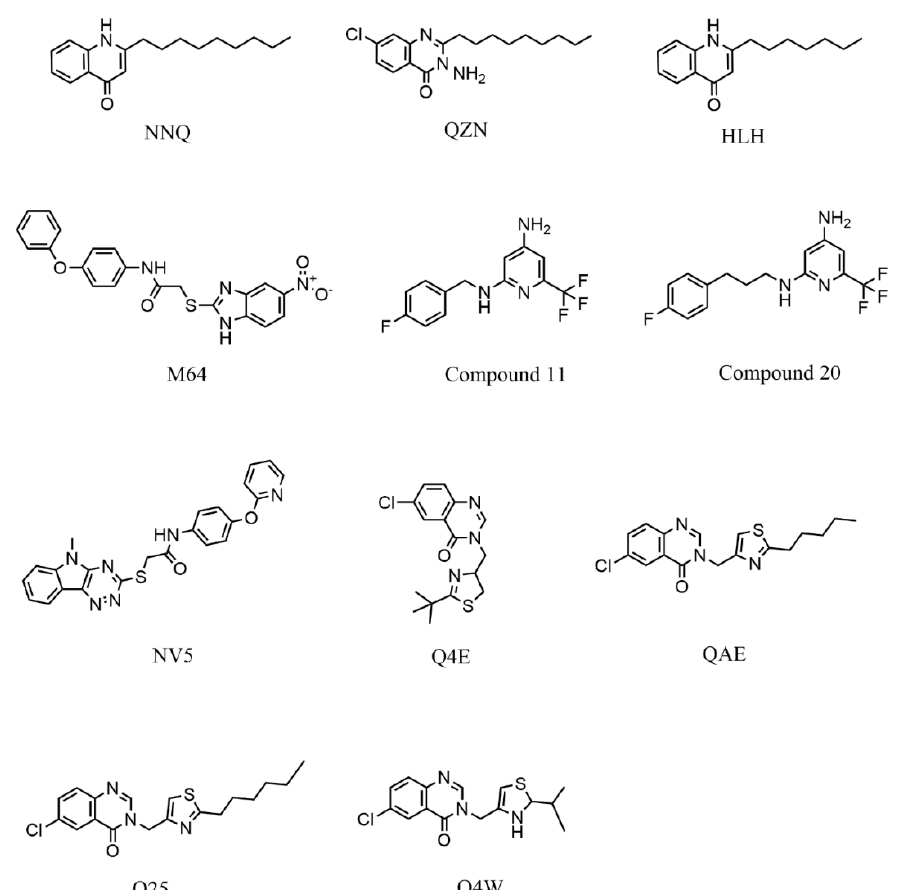
Figure 10. Chemical structures of the six crystallographic ligands.